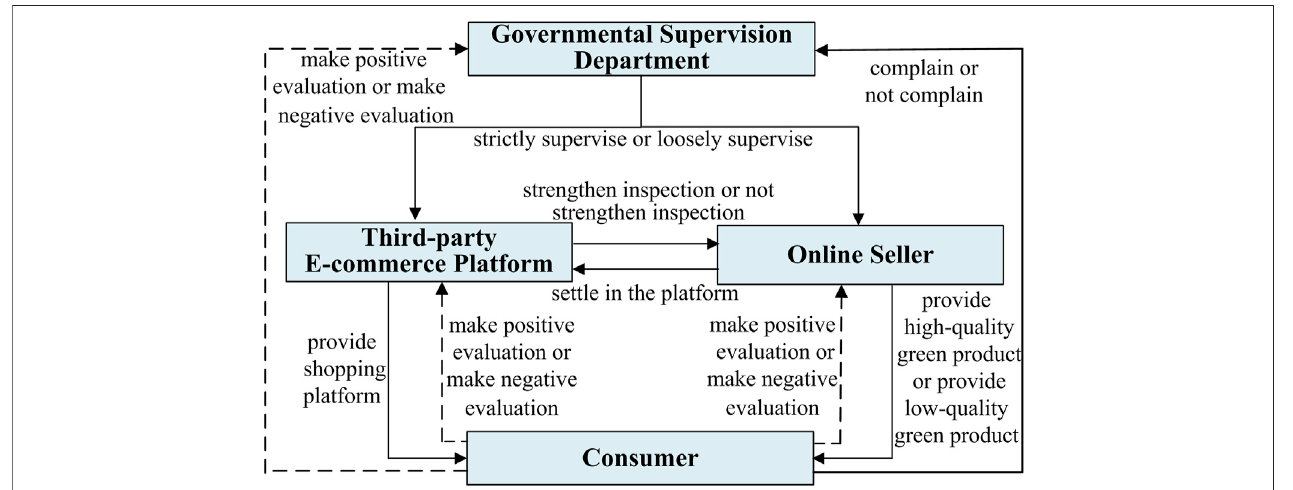
FIGURE 1 | The structure relationship of green product quality supervision in online